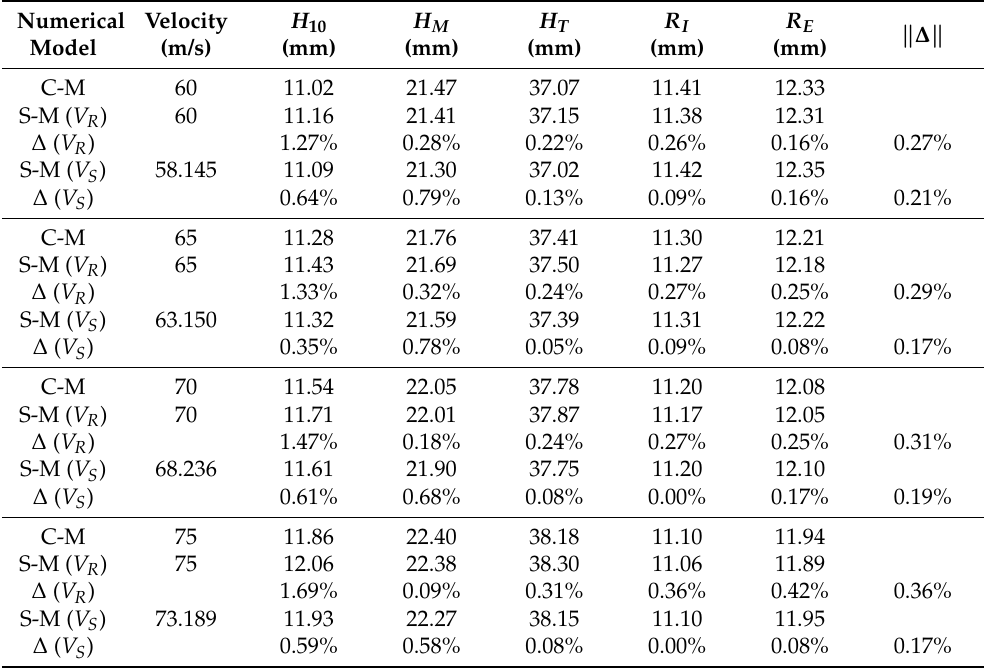
Table 6. Identification of the equivalent impact velocity for the simplified model of dynamic tensile test.